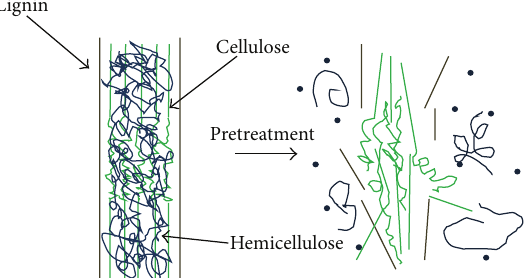
Figure 6: Deconstruction of lignocelluloses into cellulose, hemicel- lulose, and